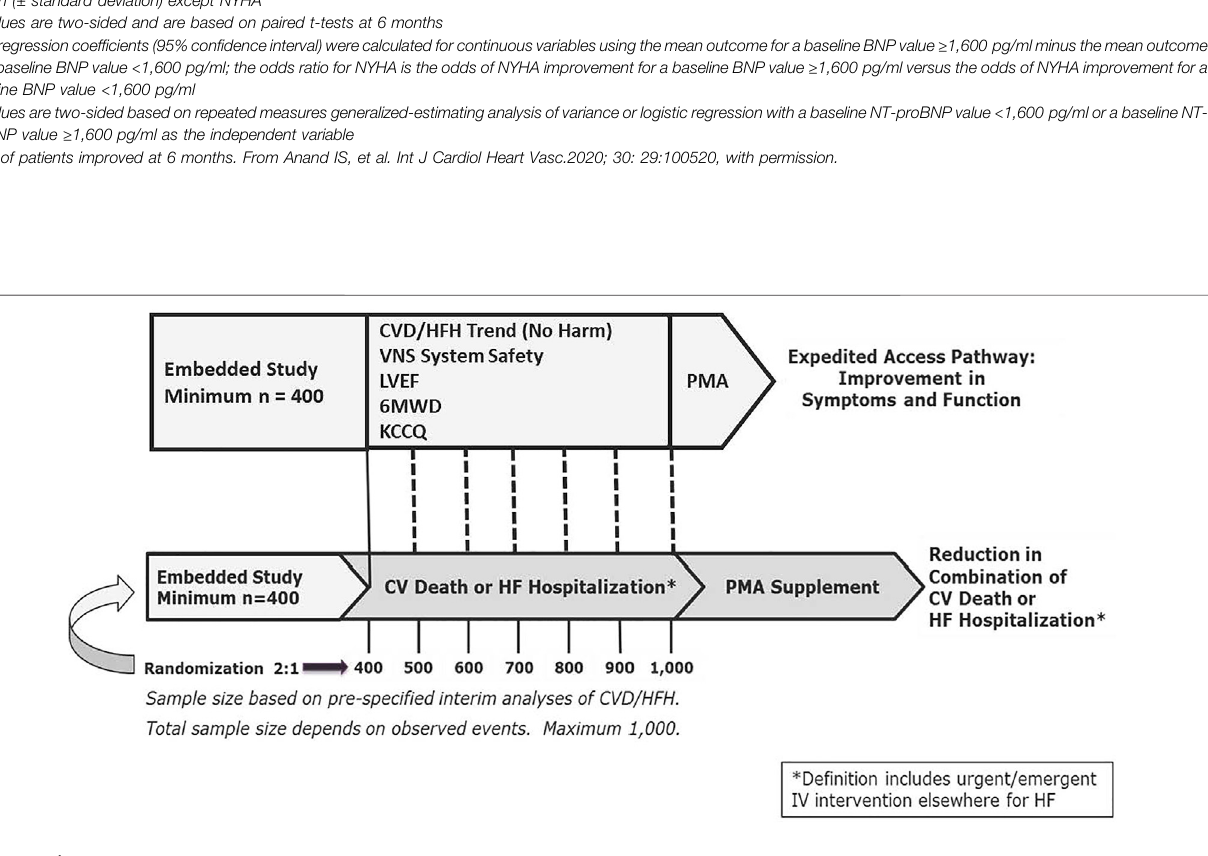
Frontiers in Physiology |